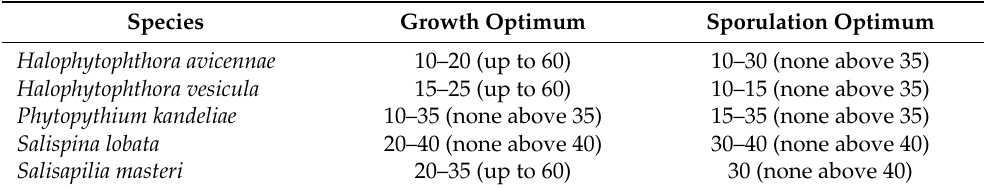
Table 3. Growth and reproduction of marine Oomycota at various concentration of seawater (‰) (adapted from